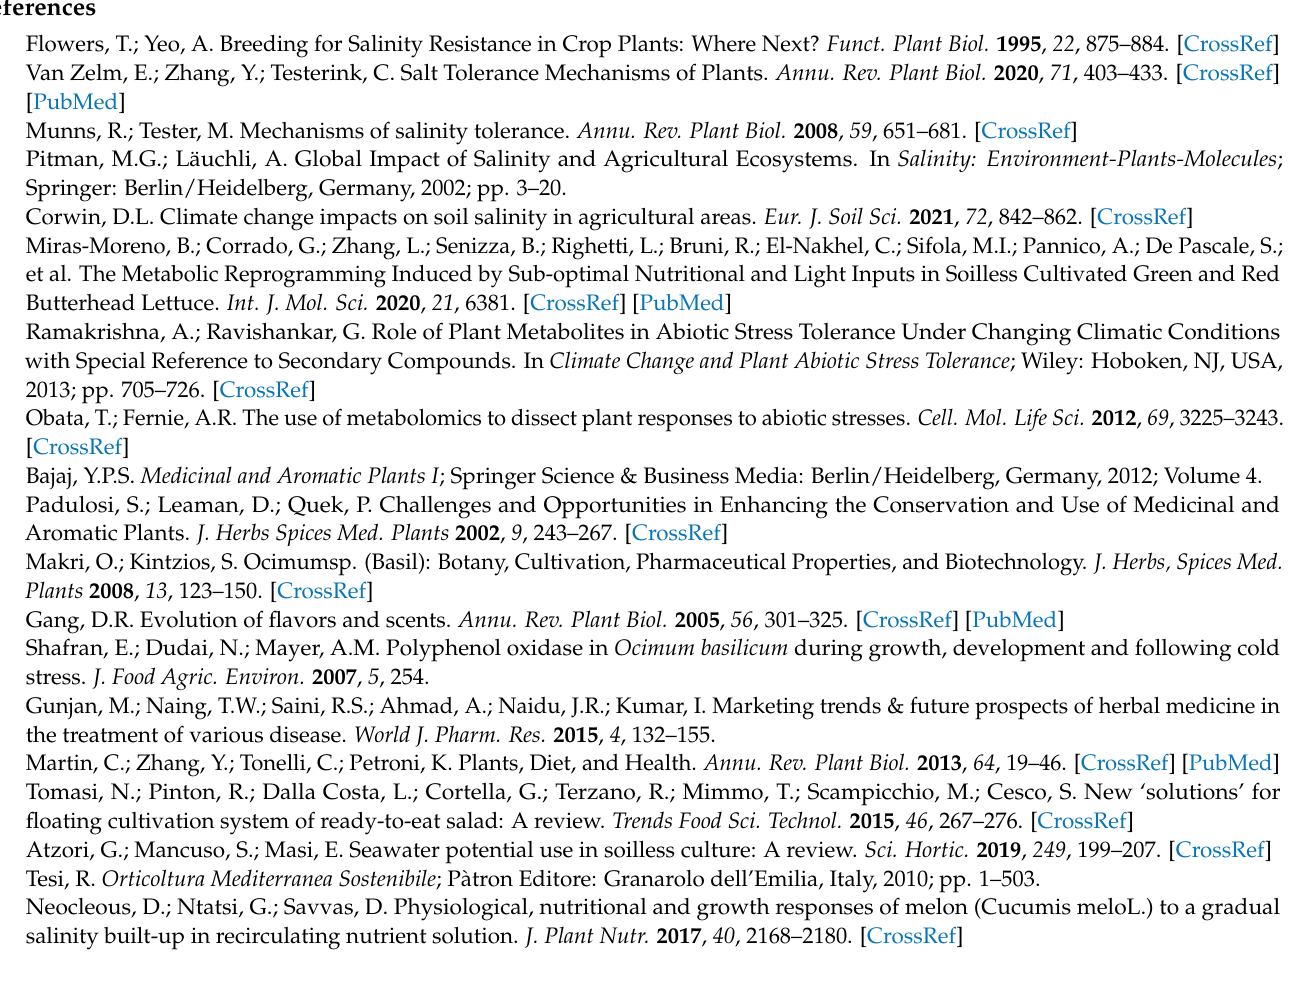
pounds identified and quantified in the basil extracts. Table S2: One-way ANOVA table of the morphometric traits. The unit of measurement of each variable is reported in brackets. Table S3: One-way ANOVA table of the SPAD index and color parameters. Table S4: One-way ANOVA table of the mineral content in basil leaves. The unit of measurement of each variable is reported in brackets. Table S5: One-way ANOVA table of the biochemical traits investigated. The unit of measurement of each variable is reported in